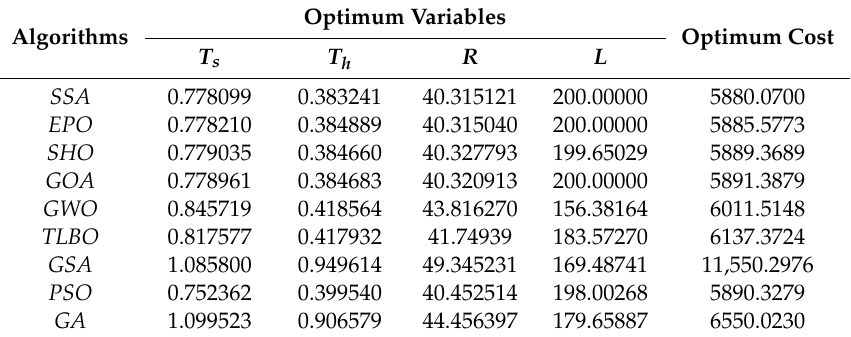
Table 5. Comparison results for pressure vessel design problem.